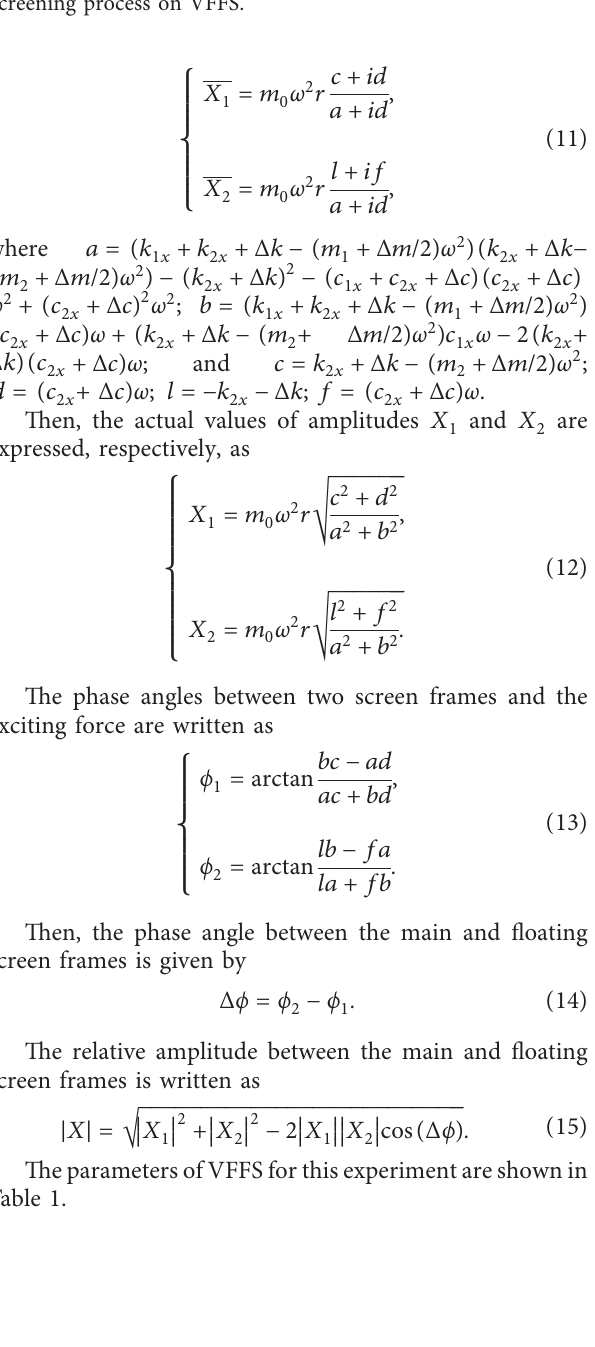
Figure 4: Schematic diagram of screening process on VFFS.